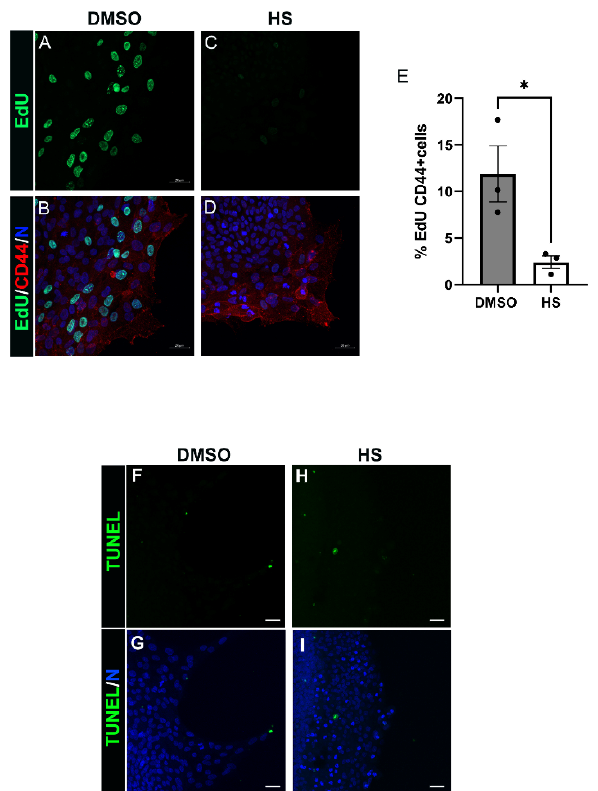
Figure 6. PI3K 110 α signals CD44 leader cell proliferation. ( A – I ) Ex vivo post-cataract surgery cultures were treated with vehicle (DMSO) or HS-173 (HS) at day 1 for 24 h and assessed for proliferation by EdU ( A – E ) or apoptosis by TUNEL analysis ( F – I ). ( A – D ) Vehicle and HS-173 treated cultures were processed for EdU incorporation, immunolabeled for CD44 and co-stained for DAPI. ( E ) Quantification of the % CD44+ cells that were EdU+ for vehicle and HS treated ex vivo post-cataract surgery cultures are displayed in the bar graph. Inhibiting PI3K α led to a significant decrease in leader cell incorporation of EdU, showing a requirement for PI3K α in mediating CD44+ leader cell proliferation. ( F – I ) Vehicle and HS-173 treated ex vivo post-cataract surgery cultures were processed for TUNEL and co-stained for DAPI and imaged at the leading edge by confocal microscopy. Treatment with HS-173 did not cause any increase in TUNEL labeling of leader cells indicating that mesenchymal leader cell survival is not mediated by PI3K α . Images are presented as a projection from the collected confocal z-stack with each optical plane at 0.49 µ m ( A – D ) or 0.6 µ m ( F – I ). Magnification bar = 20 µ m. Error bars represent S.E.M., * p ≤